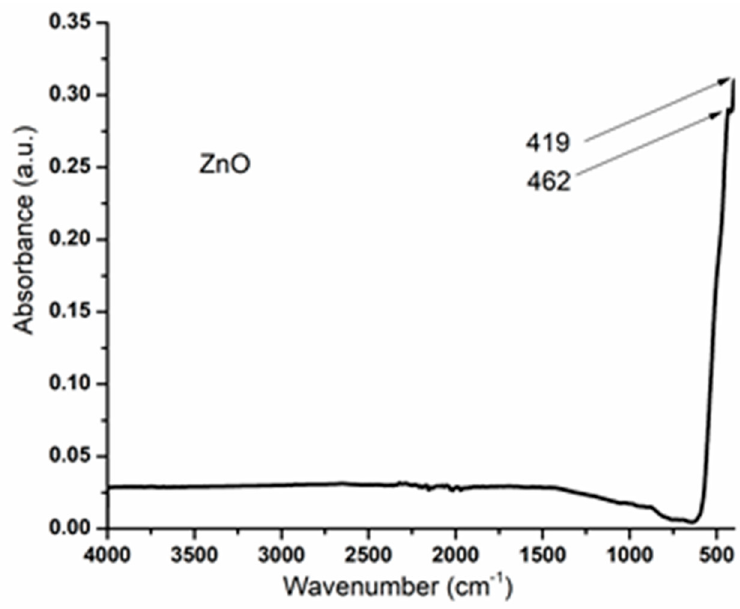
Figure 3. FTIR spectra of ZnO nanoparticles.